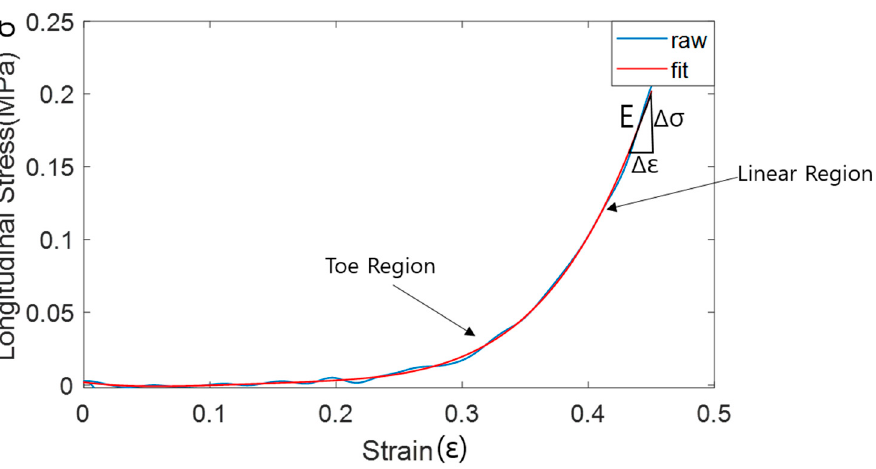
Figure 2. An example of the raw and fitted strain vs stress curve in the longitudinal direction.